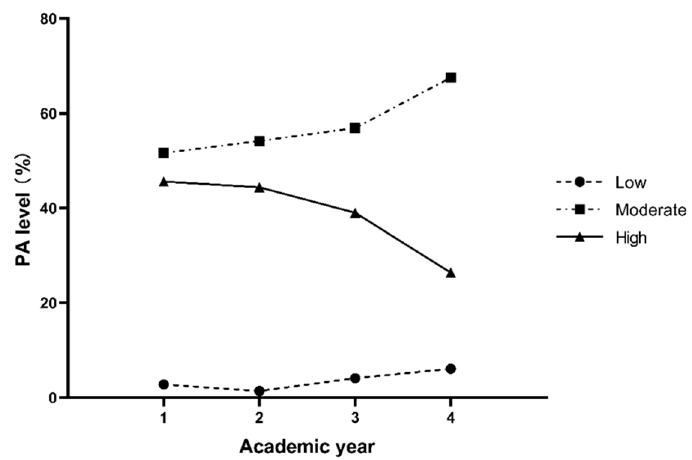
Figure 2. The percentages of the three levels of PA in each academic year for females.